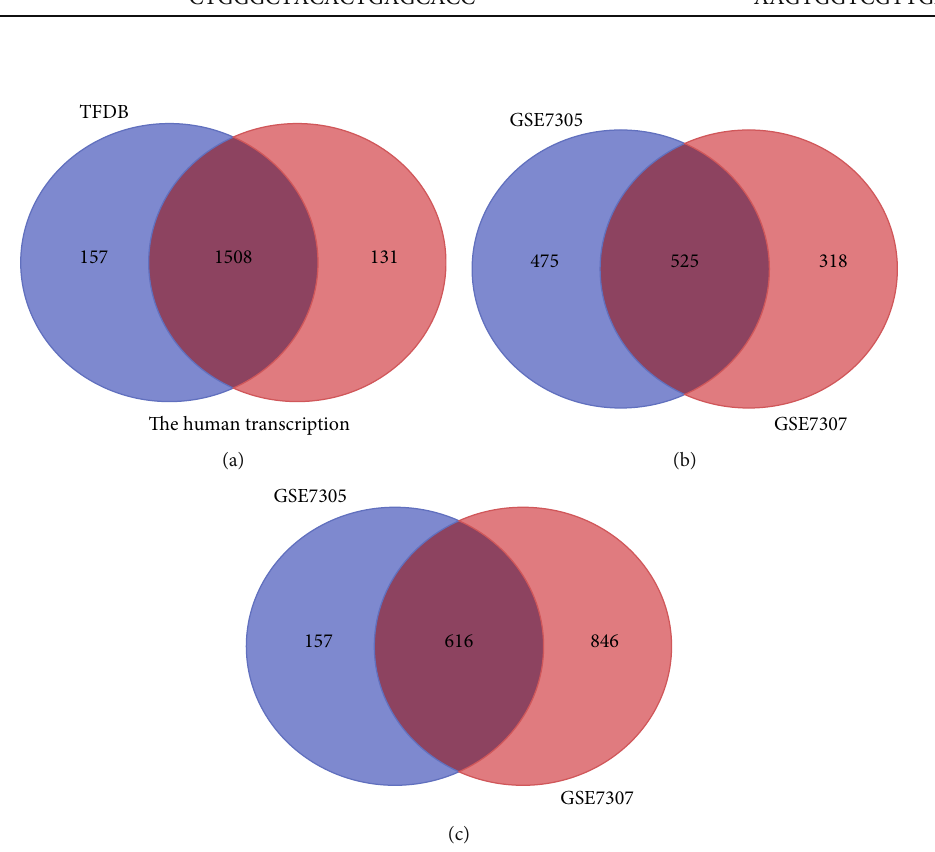
Figure 1: Identi fi cation of DETFs and 111 DEGs in endometriosis. (a) Identi fi cation of 1508 TFs from two TF databases (Human TFDB and The Human Transcription Factors). (b, c) Identi fi cation of 525 upregulated and 616 downregulated DEGs from GSE7305 and